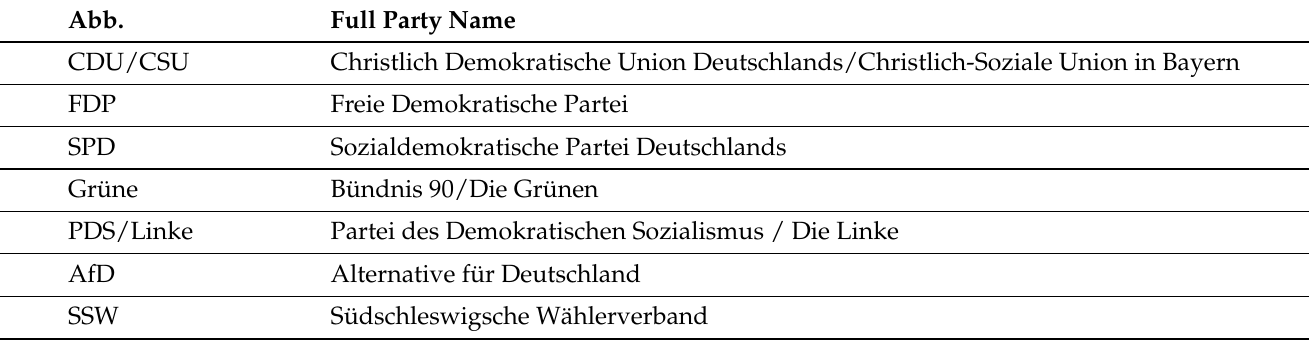
Table 10. German federal parliament, 1994–2021: